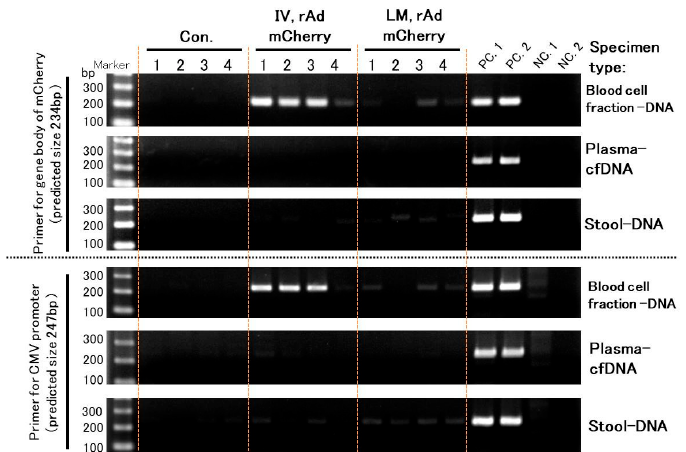
Figure 3. Detection of transgene fragments in representative samples using semi-quantitative PCR (sqPCR). Blood cell fraction DNA samples show strong signals, but other samples show very weak signals. IV means intravenous injection, and LM means local muscular injection of the rAdV vectors in the tibialis anterior (TA) muscle. PC. 1: positive control of rAdV DNA containing the mCherry gene (10 pg/µL). PC. 2: positive control of liver DNA containing the mCherry gene with a rAdV induction (10 ng/µL). NC. 1: negative control of mouse DNA (50 ng/µL). NC. 2: Distilled water (DW) as a negative control. Table 3. Detection of transgene fragments from qPCR. A high number of transgene fragments was detected in the blood cell fraction DNA in the IV group. IV means intravenous injection, and LM means local muscular injection of the rAdV in the tibialis anterior (TA) muscle. a: p < 0.01 vs. control (con.) within same specimens. b: p < 0.05 vs. local injection within same specimens. c: p < 0.05 vs. con. within same